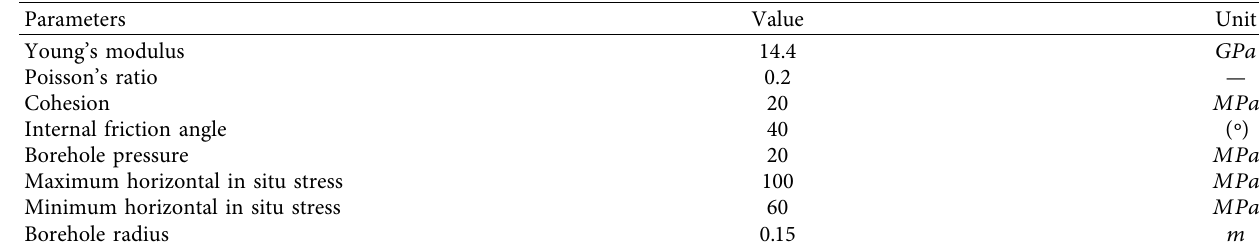
Figure 9: Depth and width of failure in diferent iterations and comparison of the numerical method in this study with other models. Table 1: Geometric and mechanical parameters [34,